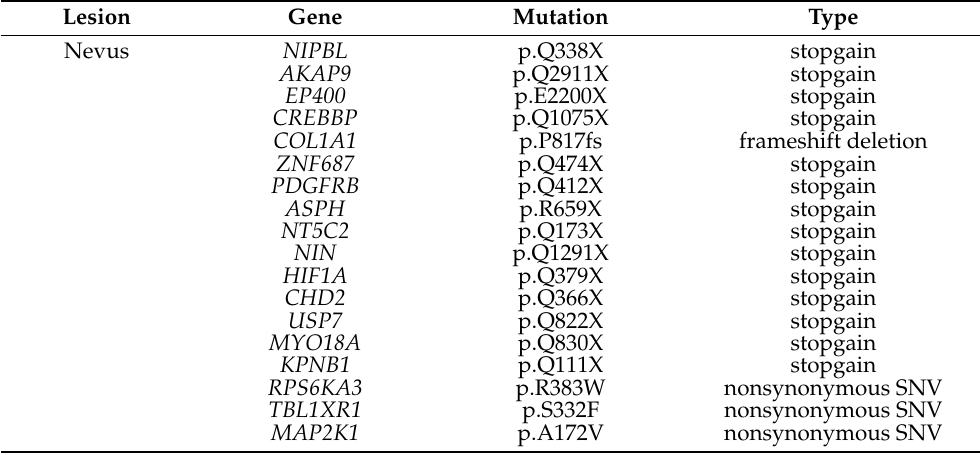
Table 1. List of genes with identified pathogenic or likely pathogenic mutations in the BAP-1 inactivated nevus, atypical tumor, and